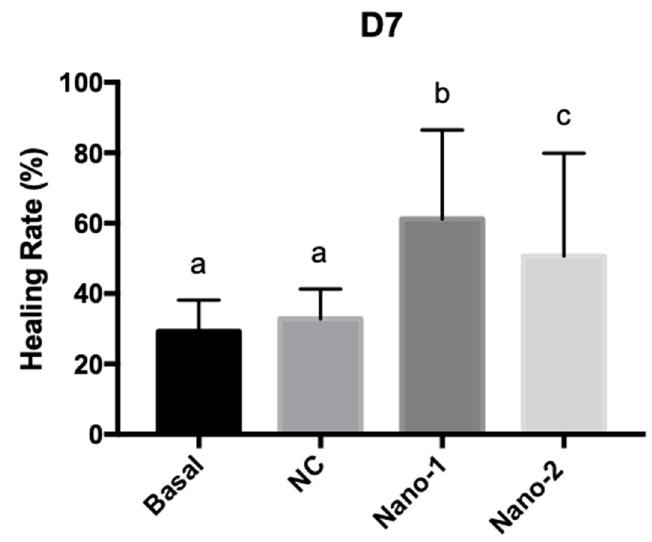
Figure 10. Graphic representation of the healing rates for human skin fragments treated daily for 7 days with culture medium (Basal), and 3.2 × 10 11 particles/mL of mineral oil control nanoemulsion (NC), Nano-1, and Nano-2. Results were statistically analyzed by ANOVA, followed by Tukey’s test. Different letters indicate statistically significant differences with P < 0.05 (n = 3 determina ‐ tions).